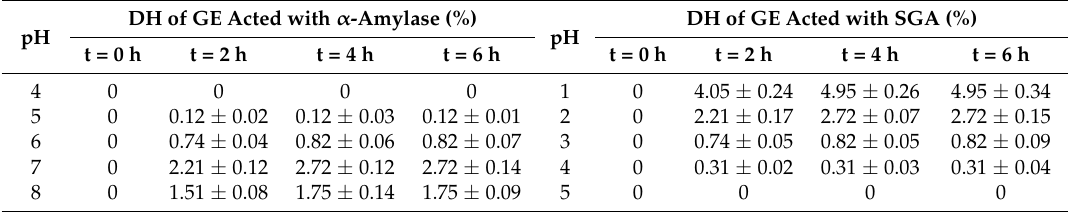
Table 2. Hydrolysis of GE under the addition of α -amylase and simulated gastric acid (SGA),